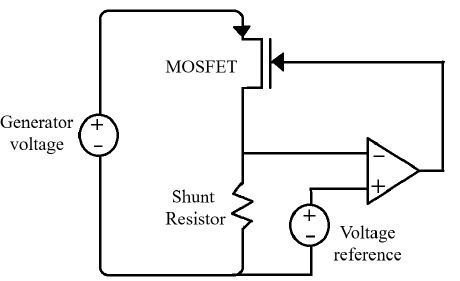
Figure 14. Electronic load circuit in constant current operation.